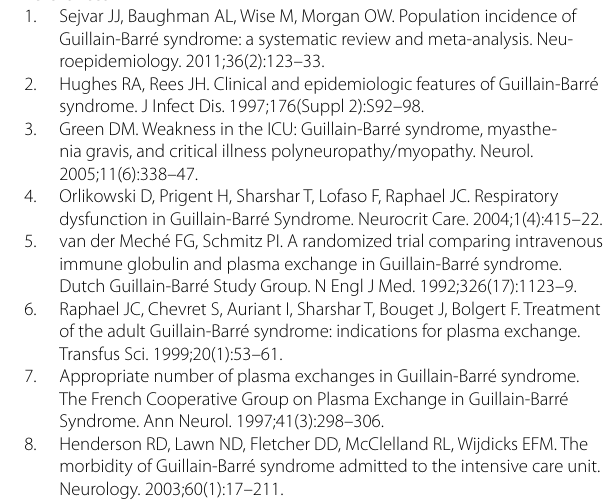
Table S1. Predominant organisms in early and late‑onset pneumonia * . Table S2. Secondary outcomes. Table S3. Distribution of serious adverse events across randomization groups *